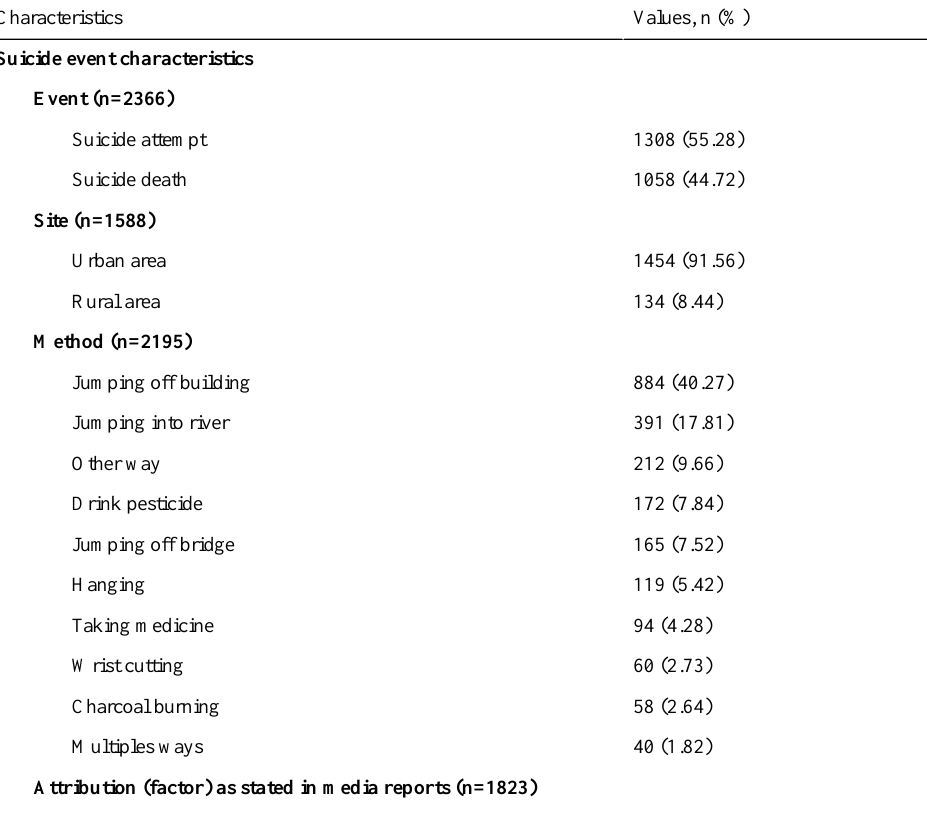
Table 3. Descriptive characteristics of suicide reporting on social media